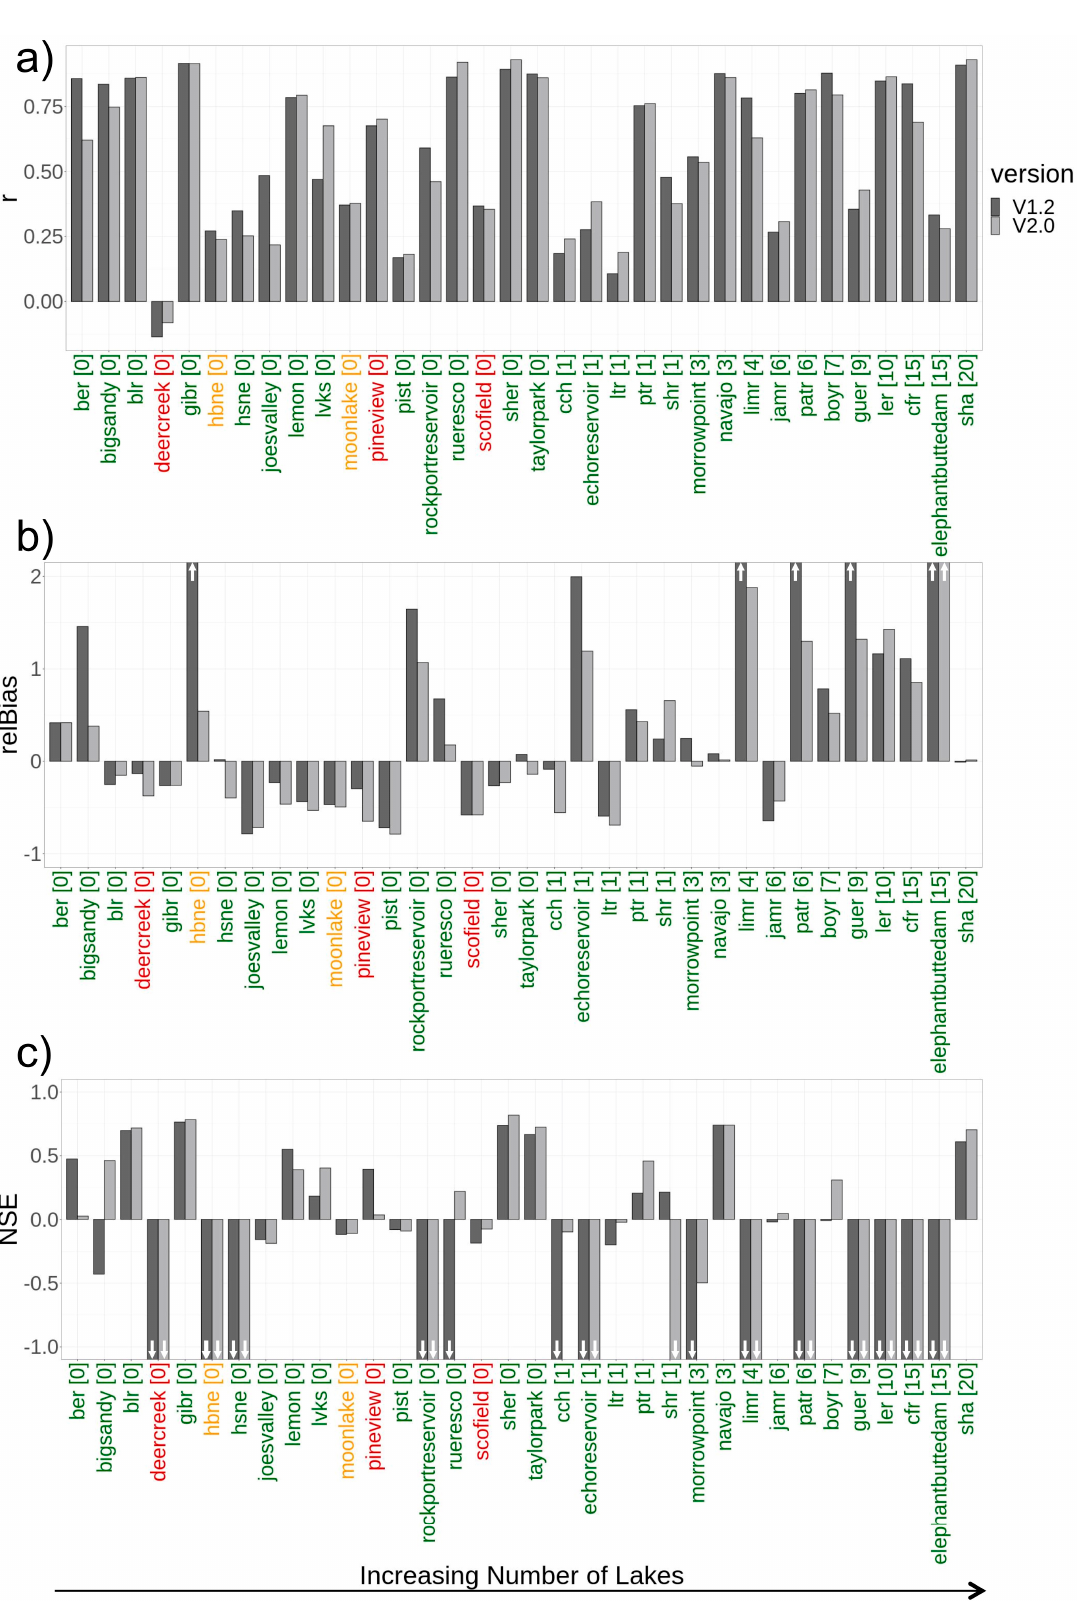
Figure 2. Goodness of fit scores from the NWM v1.2 (dark grey) and NWM v2.0 (light grey) retrospective total inflow evaluation, ordered by increasing number of lakes. From top to bottom: r ( a ), relBias ( b ) and NSE ( c ).